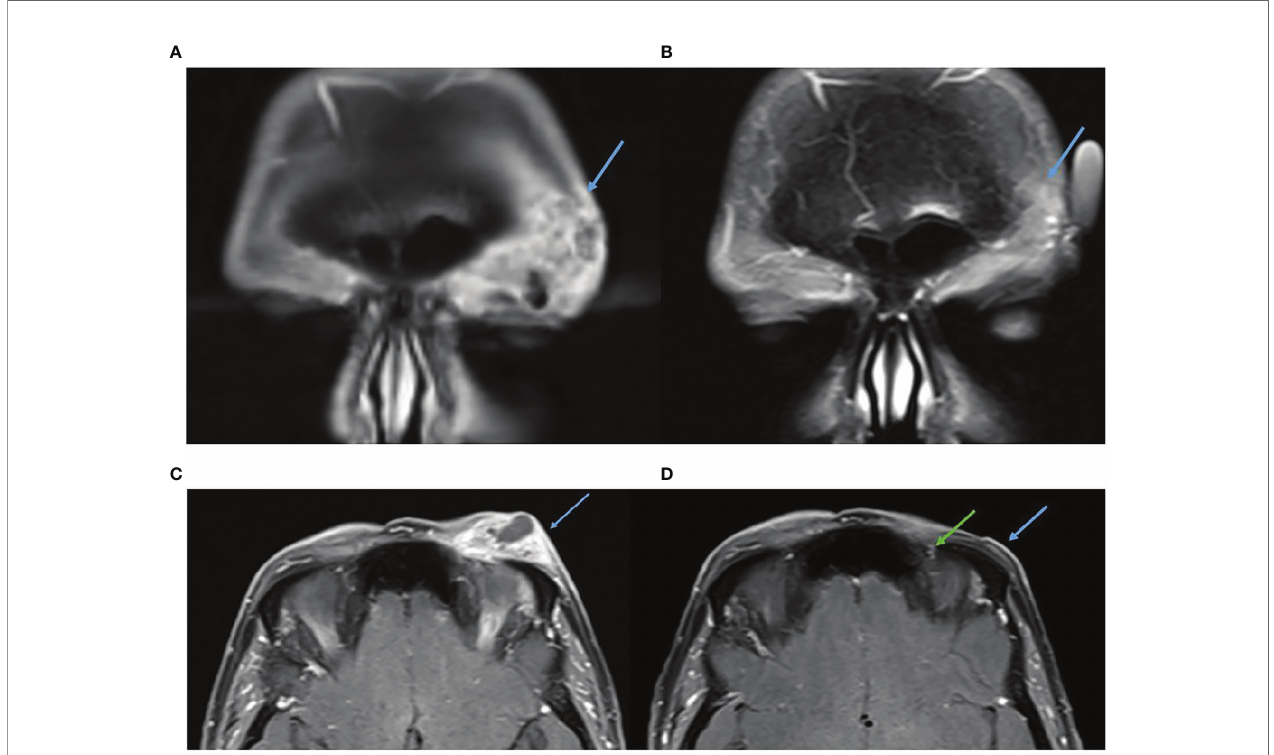
FIGURE 6 | (A) Baseline, left, MRI post contrast T1 Fat Sat demonstrating 39 × 16 mm left forehead enhancing mass. (B) MRI post contrast T1 Fat Sat, post 16 cycles of cemiplimab 350 mg/3-weekly, demonstrating response. (C) Baseline, left, MRI post contrast T1 Fat Sat demonstrating 39 × 16 mm left forehead enhancing mass. (D) MRI post contrast T1 Fat Sat, post 16 cycles of cemiplimab 350 mg/3-weekly, no mass like enhancement and only small volume residual enhancement of the left supraorbital nerve, green